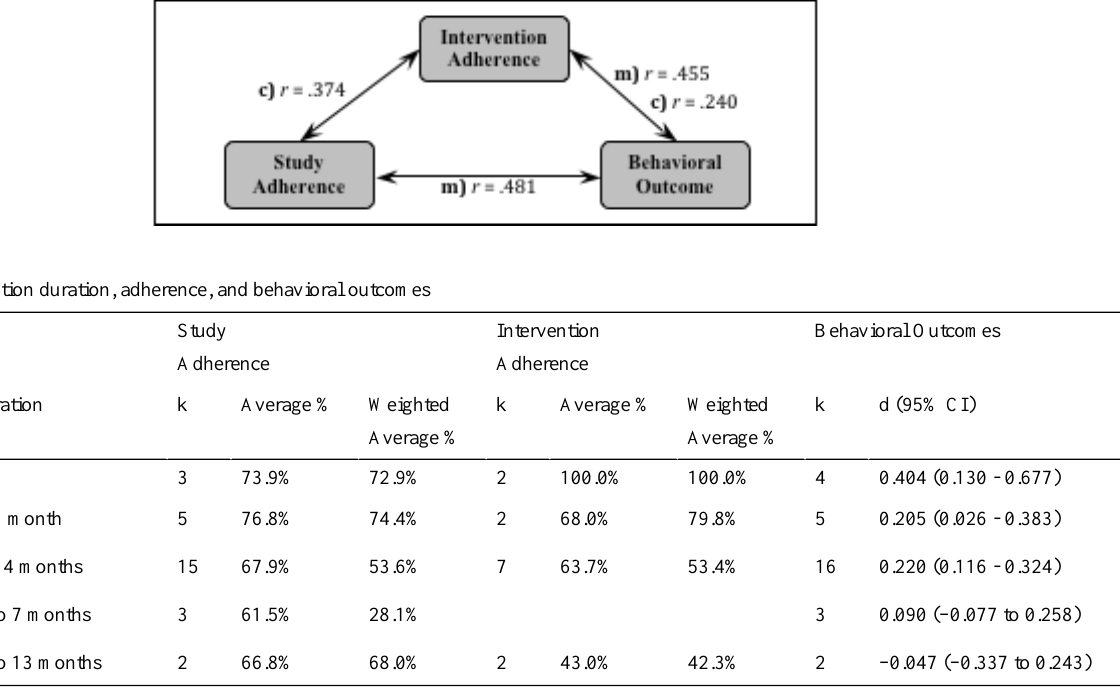
Figure 6. Correlations between adherence variables and effect size (c = correlation effect size, m=meta-regression effect size)